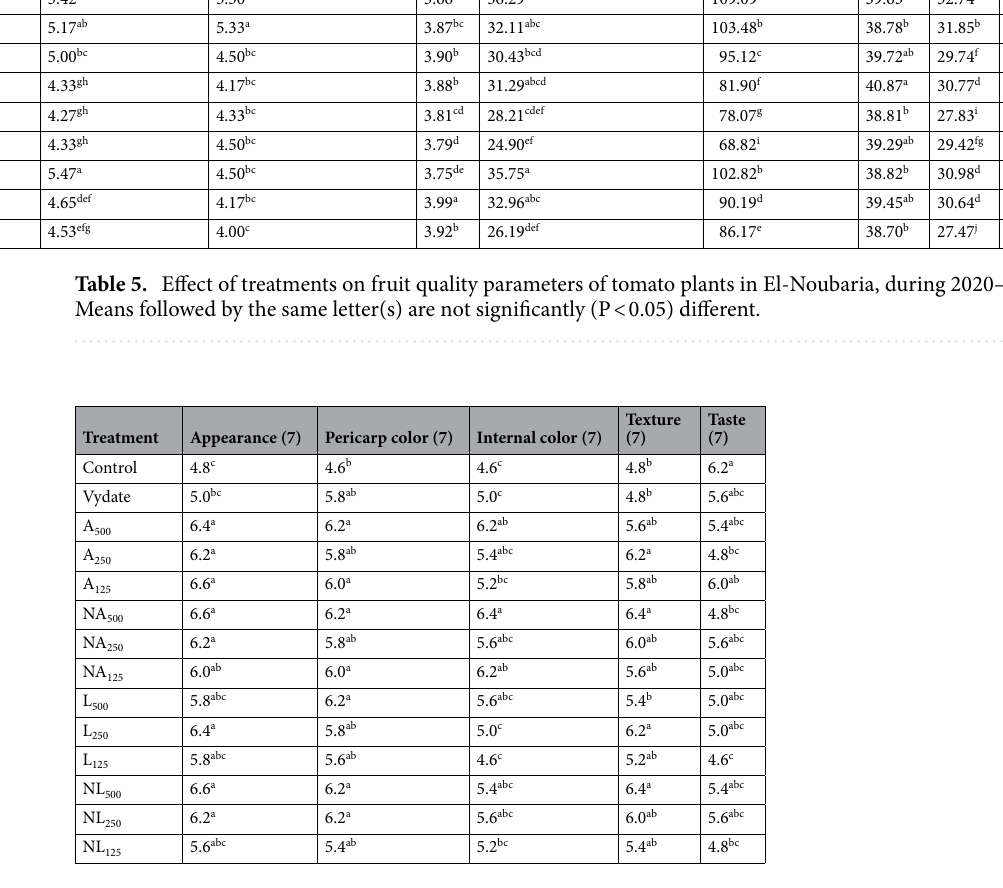
Table 6. Effect of A. annua and L. sativum extracts and their nano-formulations on the organoleptic properties of tomato fruits. Means followed by the same letter(s) are not significantly (P < 0.05)